Question: Sum up the contents of this chart in one sentence.
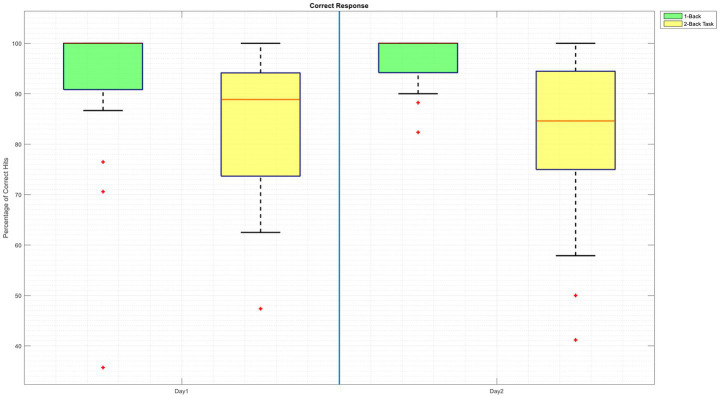
Answer: N-back response accuracy plot for different difficulty levels.